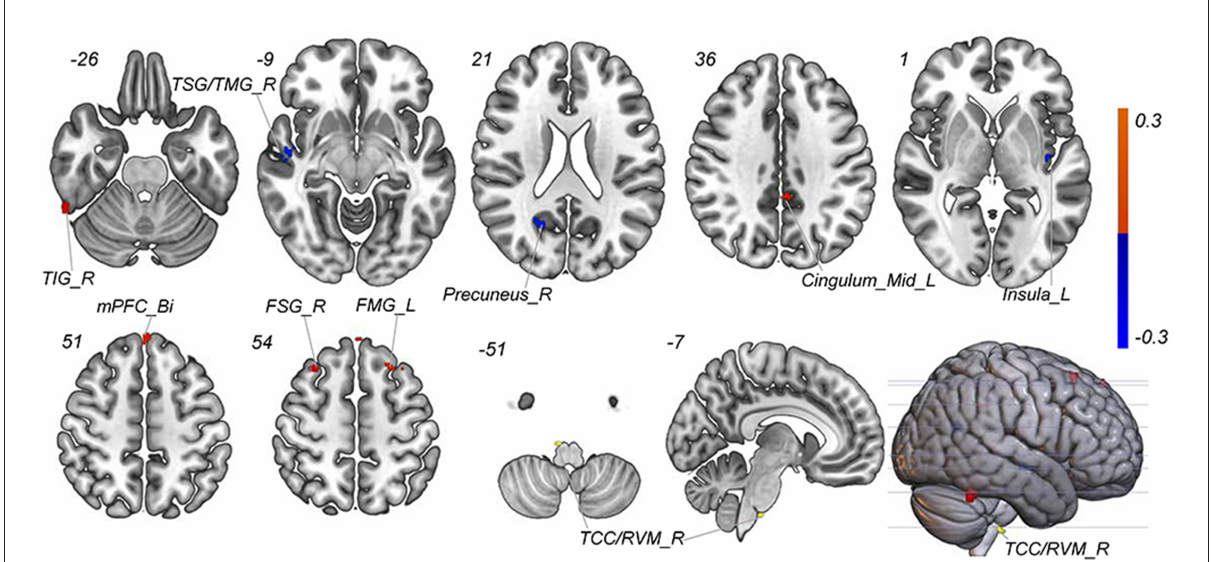
FIGURE5 Predictive features to predict the efficacy of tVNS based on the classification model. Red means positive weight and blue means negative weight. The main weight brain areas were located in TCC/RVM, mPFC, TSG, and Insula. Bi, bilateral; FSG, frontal superior gyrus; FMG, frontal middle gyrus; L, left; mPFC, medial prefrontal gyrus; R, right; RVM, rostral ventromedial medulla; TCC, trigeminal cervical complex; TSG, superior temporal gyrus.